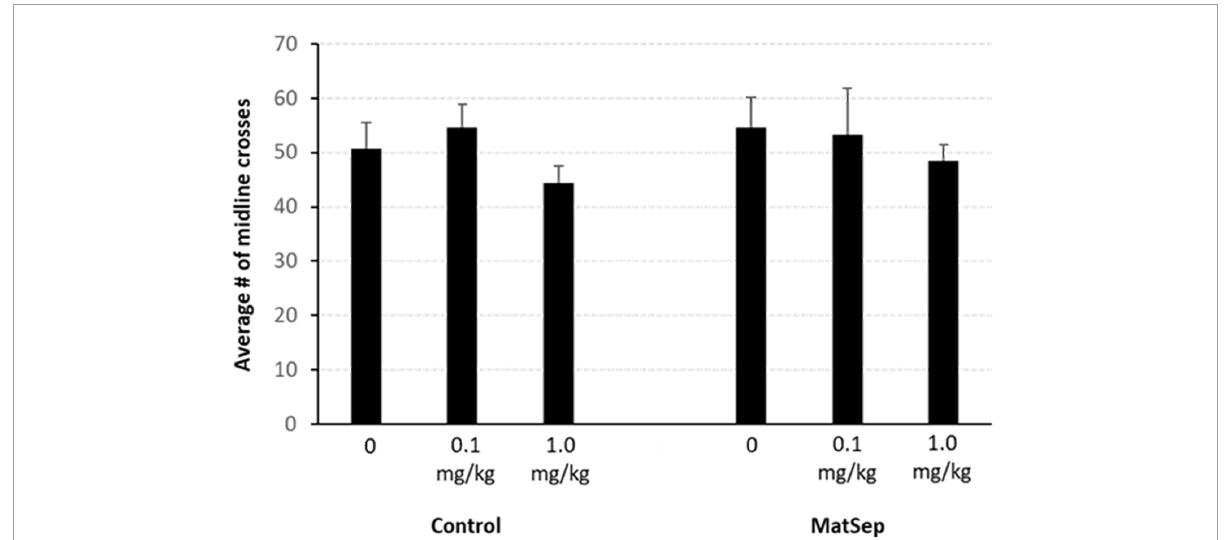
FIGURE3 Locomotor activity is not affected by MatSep or Meth administration. Locomotor activity was quantified as the number of times an animal crossed the midline of the CPP apparatus, in transition from one chamber to the other. No significant differences were seen, regardless of treatment group or drug dose used for conditioning ( n = 5–8/group).